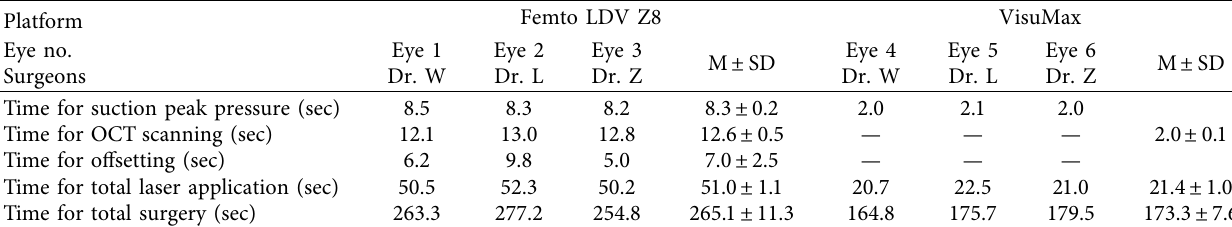
Table 3: Treatment durations of the two femtosecond laser